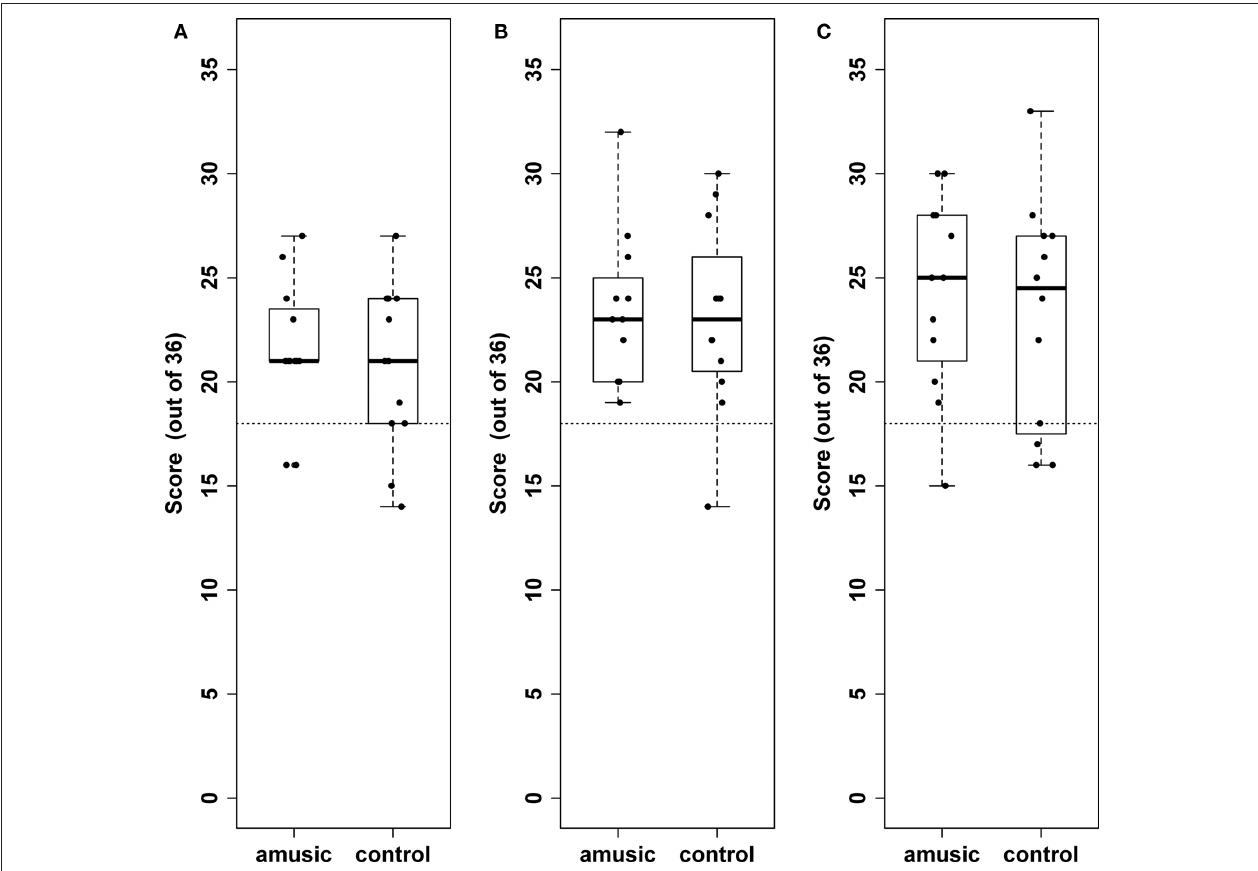
FiGuRe 3 | Boxplots showing performance on the linguistic (A) supra-threshold tonal (B) and sub-threshold tonal (c) conditions for amusic and control participants. Black dots represent an individual. Median performance is represented by the solid black bar. Chance performance is represented by the dotted line.